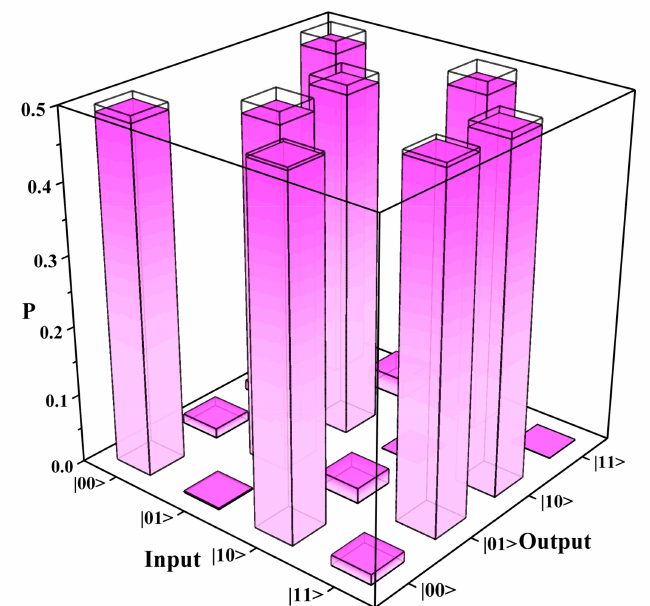
Figure 6. Reconstructed truth table of combined chip composed of one H gate and one CNOT gate. The labels on the Input axis represent P represents the probability for each input-output combination. The empty bars stand for the theoretical values, and the filled pink bars represent the experimental data. The average fidelity is as high as 98.8 ±